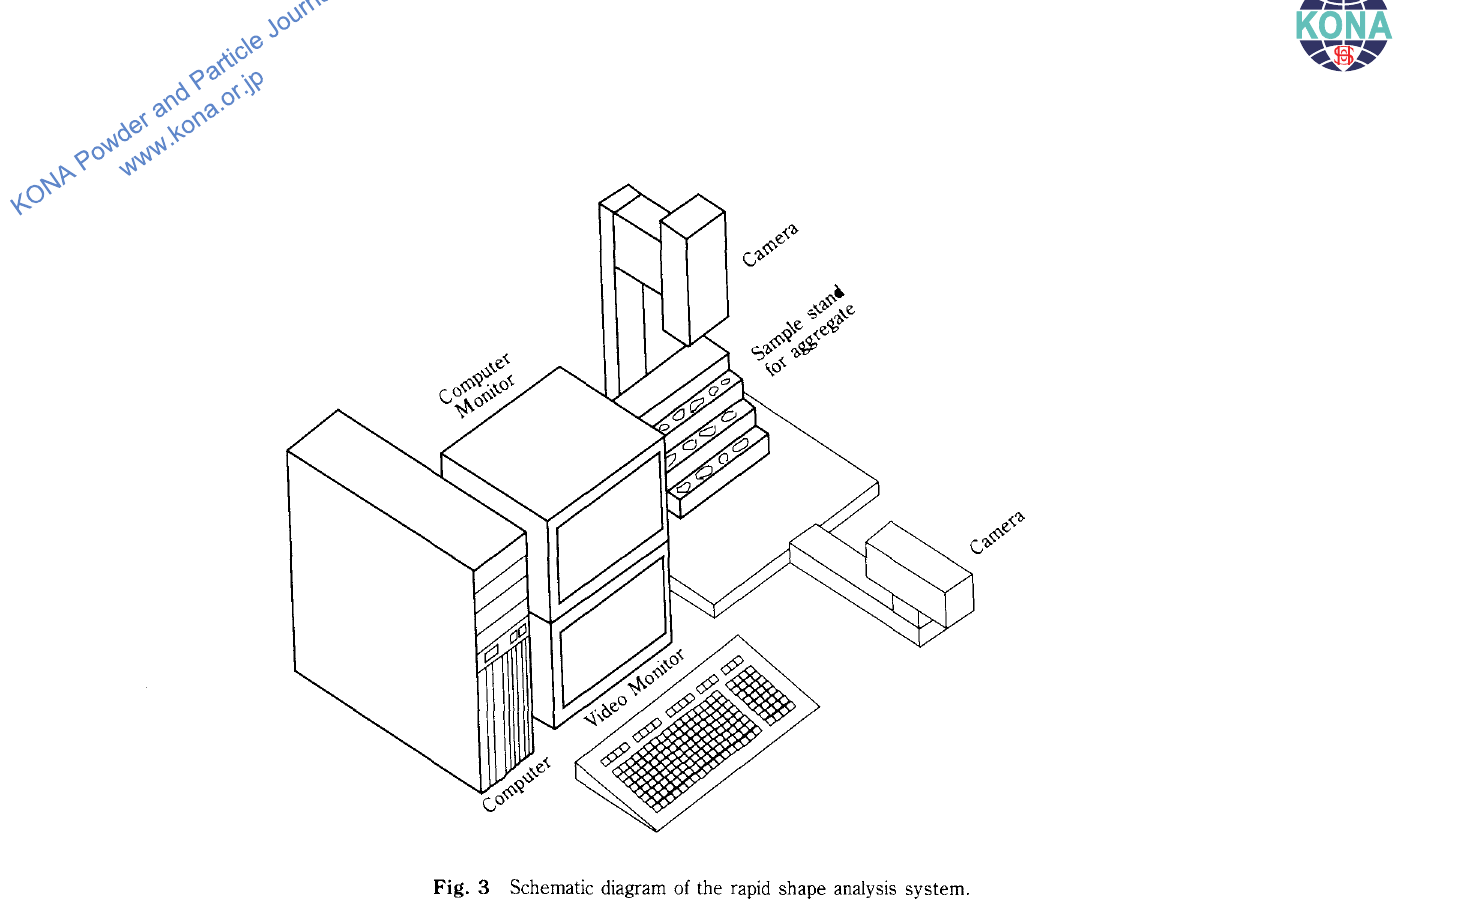
Fig. 3 Schematic diagram of the rapid shape analysis